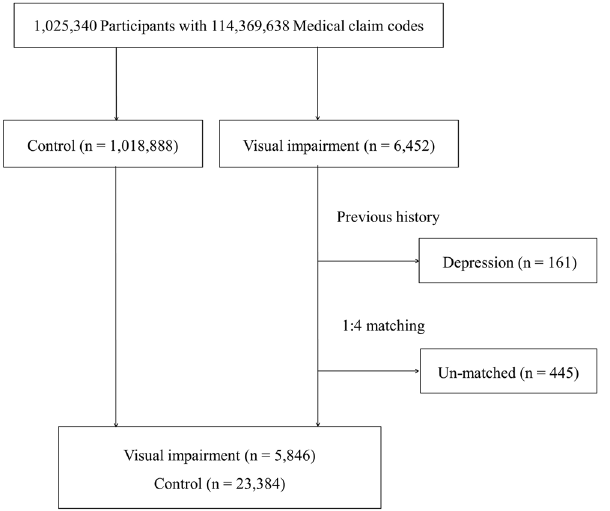
Figure 1. Flowchart of patient selection in the present study. Among a total of 6,452 visually impaired participants, those with a history of depression prior to visual impairment (n = 161) and those who could not be matched with a sufficient number of control participants (n = 445) were excluded. Data from 5,846 visually impaired participants and 23,384 control participants were subsequently